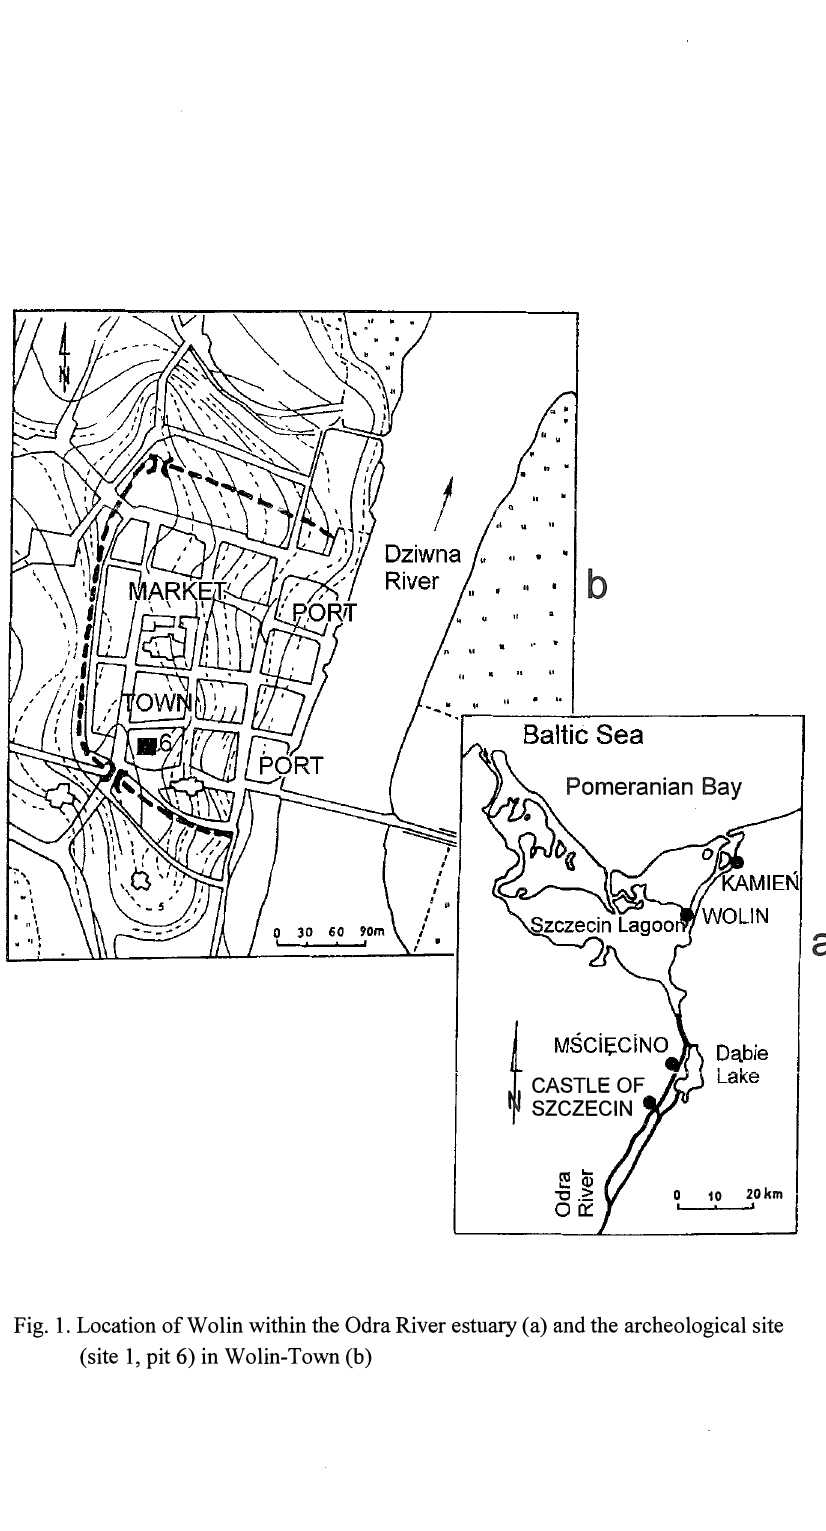
Fig. 1. Location of Wolin within the Odra River estuary ( a) and the archeological site (site 1, pit 6) in Wolin-Town